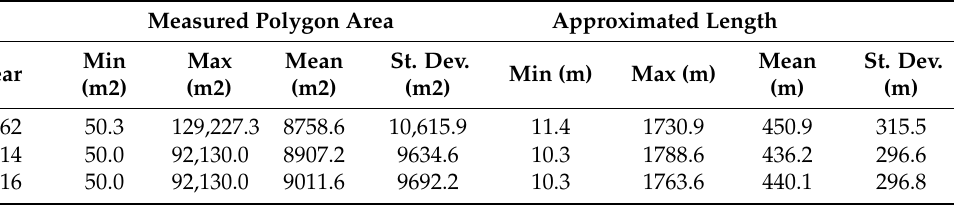
Table A1. Statistical summary of approximated shelterbelt lengths and measured polygon areas for the three years of data.